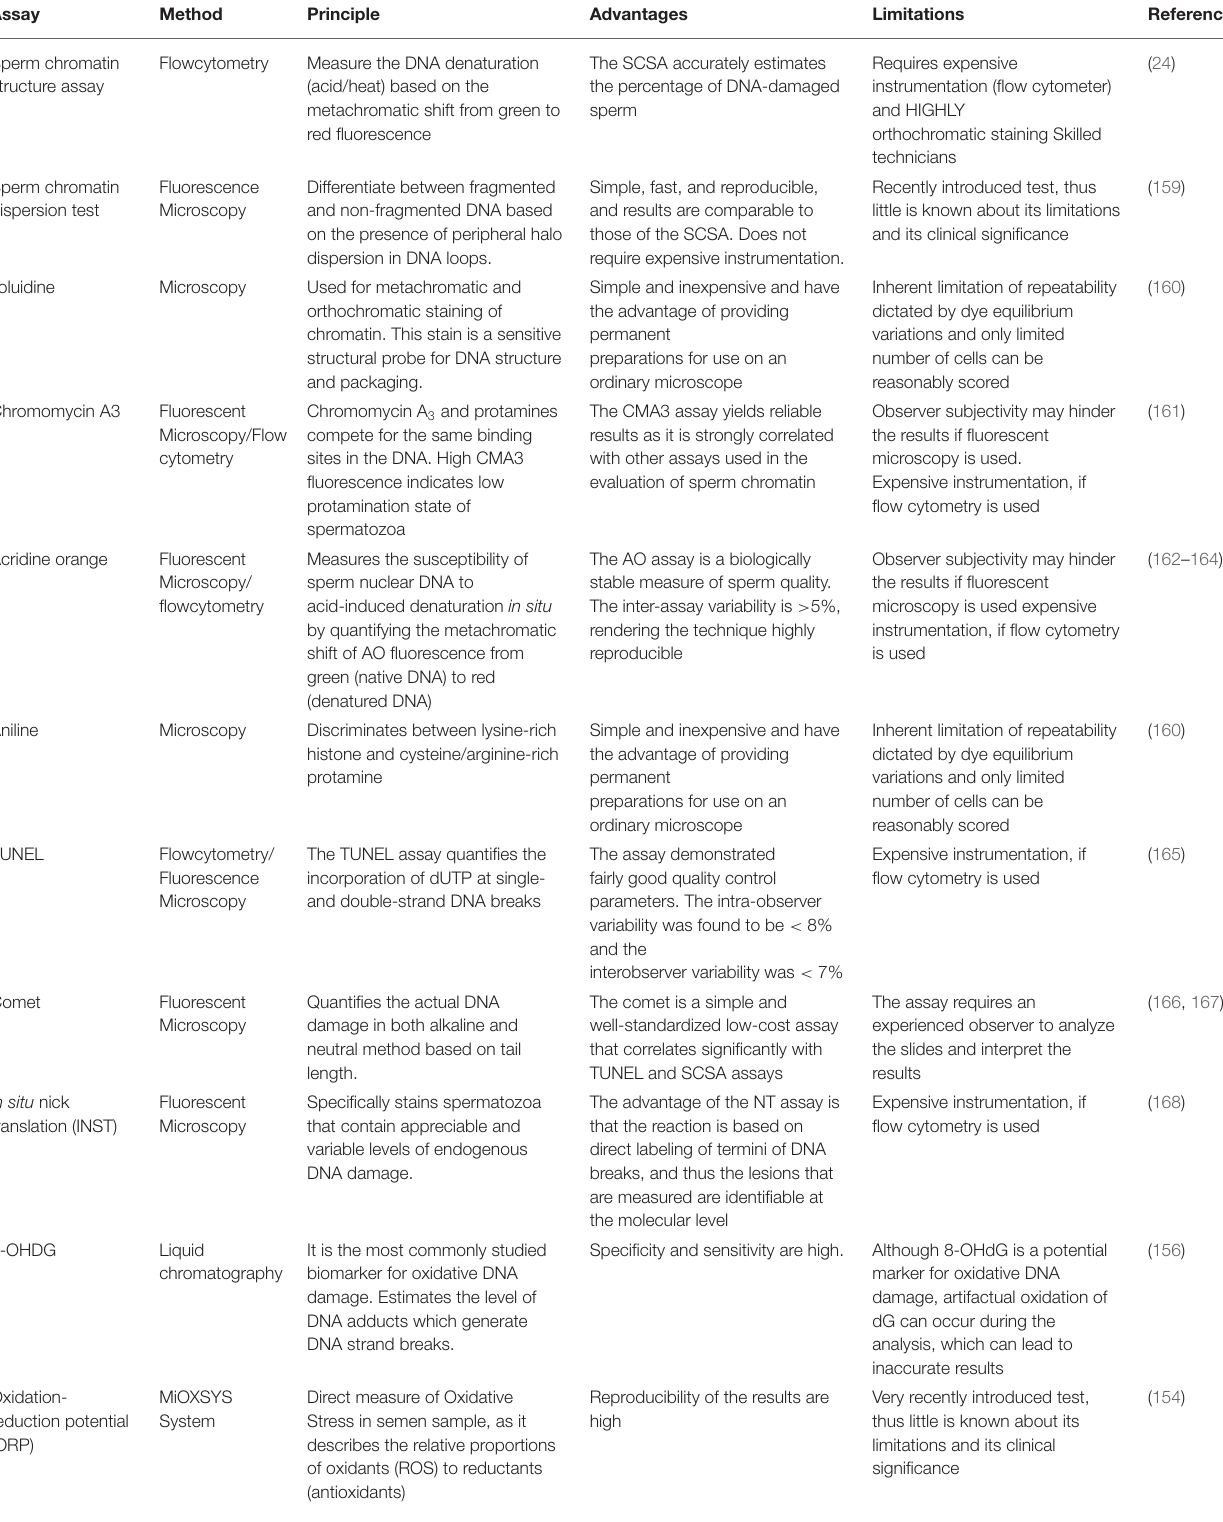
TABLE 3 | Different methods for detection of DNA damage in spermatozoa.